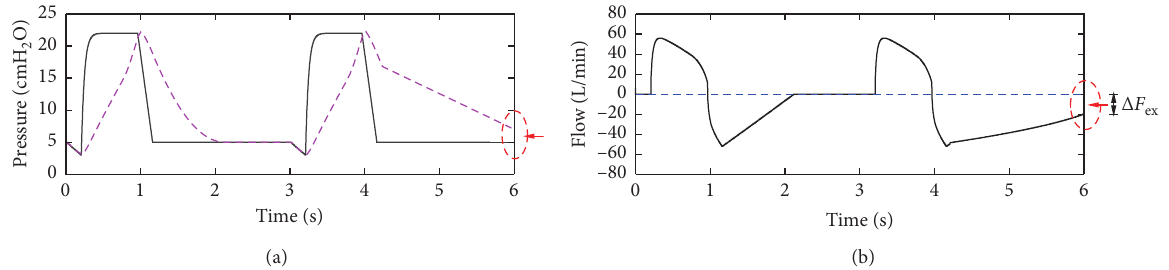
Figure 12: Ventilator waveforms of breathing cycles with the presence of PEEPi. The pink dotted line represents the curve of the intrapulmonary pressure, and the blue dotted line represents the baseline of the flow curve.